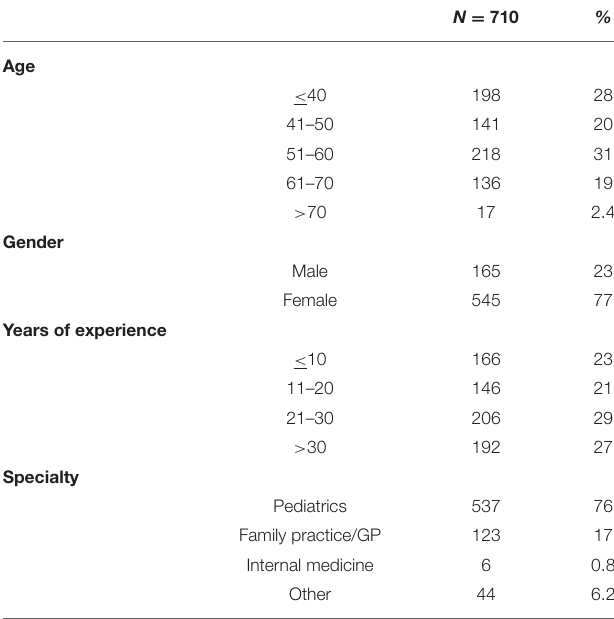
TABLE 1 | Demographic characteristics of participant